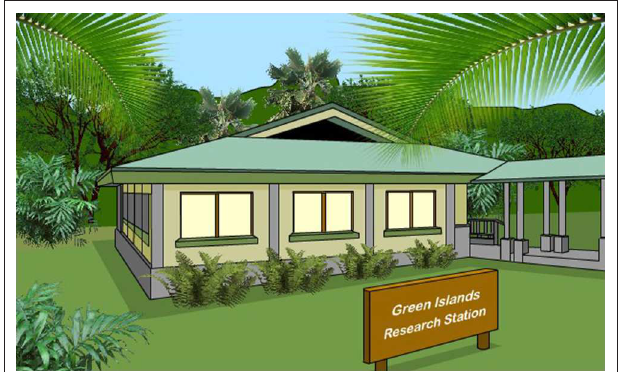
FIGURE 3 | Example of a visual of the Green Islands Research Station.